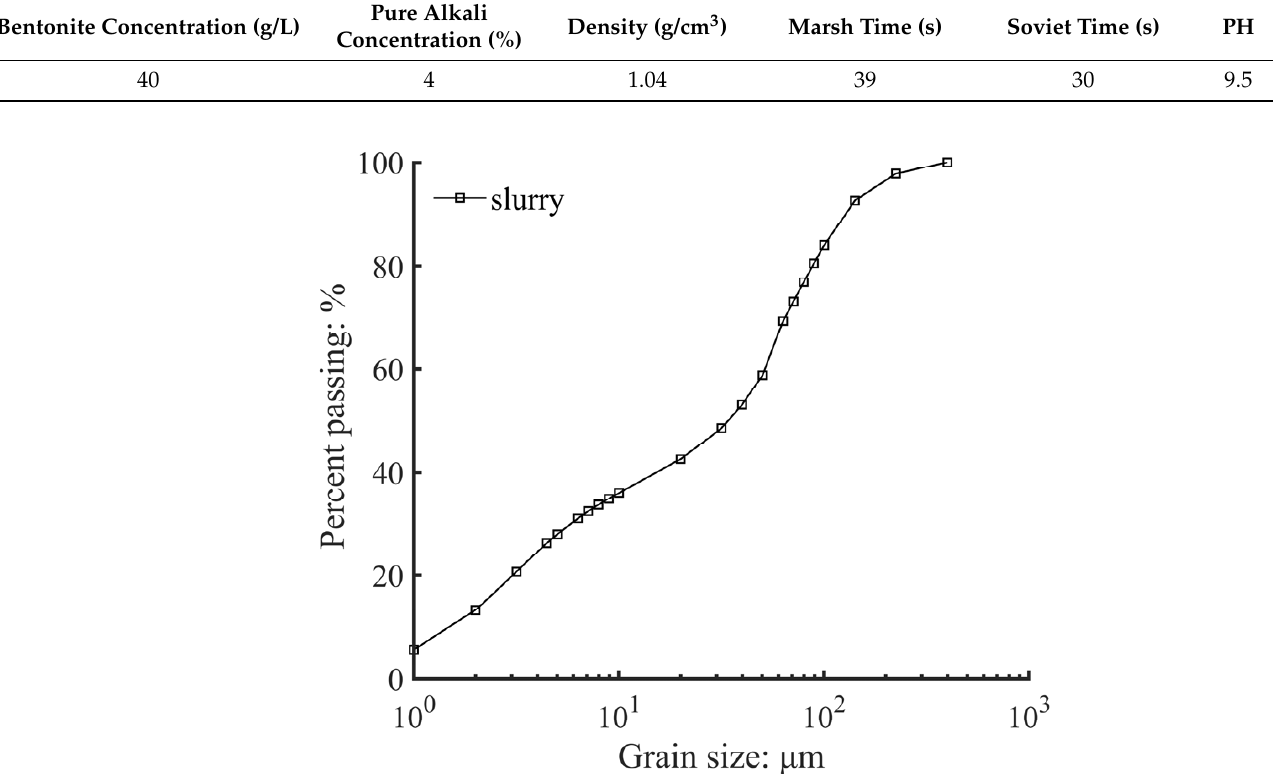
Figure 4. Grain size distribution of fresh slurry.